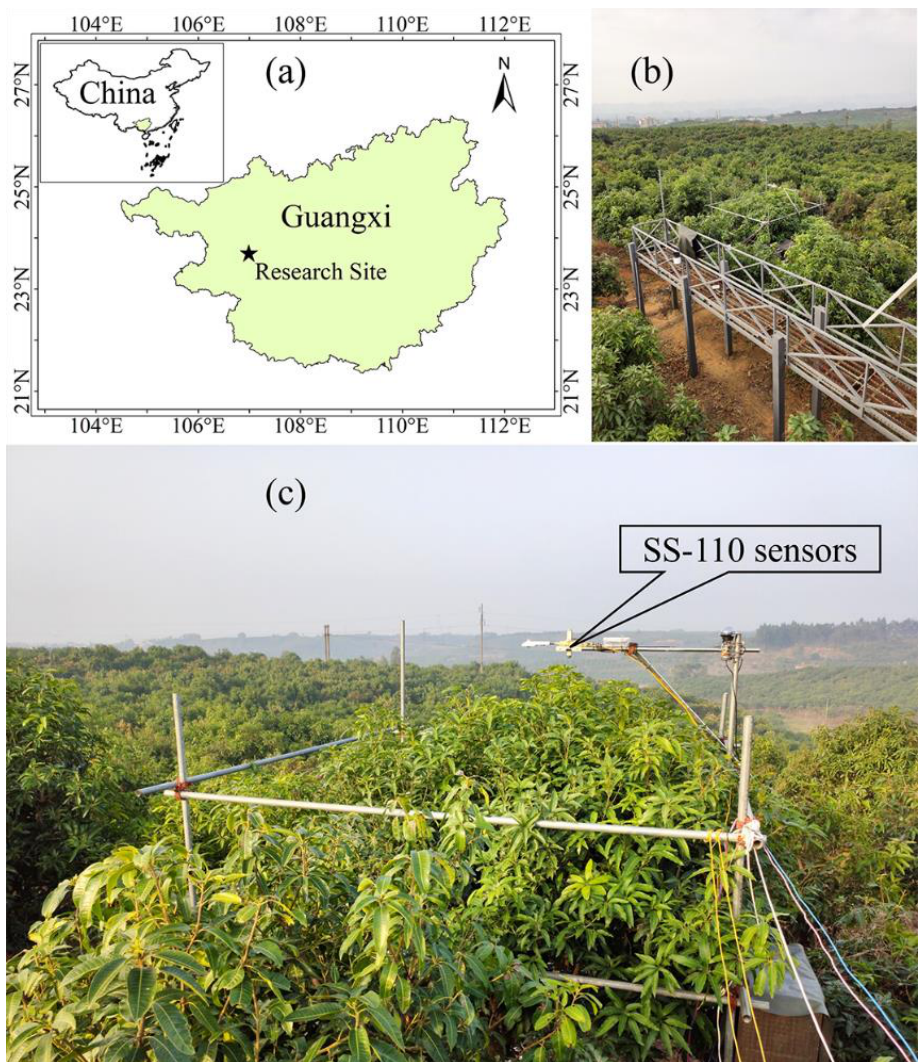
Figure 1. Research site location ( a ), an overview of the plot ( b ), and the setting of SS-110 spectrometers over the canopy ( c ).